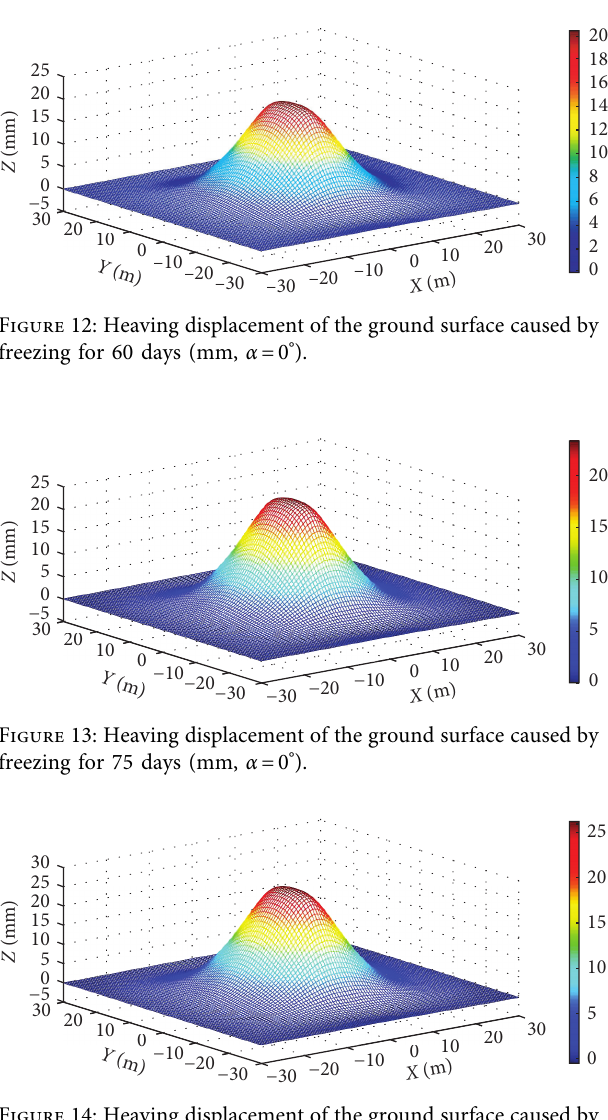
Figure 14: Heaving displacement of the ground surface caused by freezing for 90 days (mm, α � 0 °